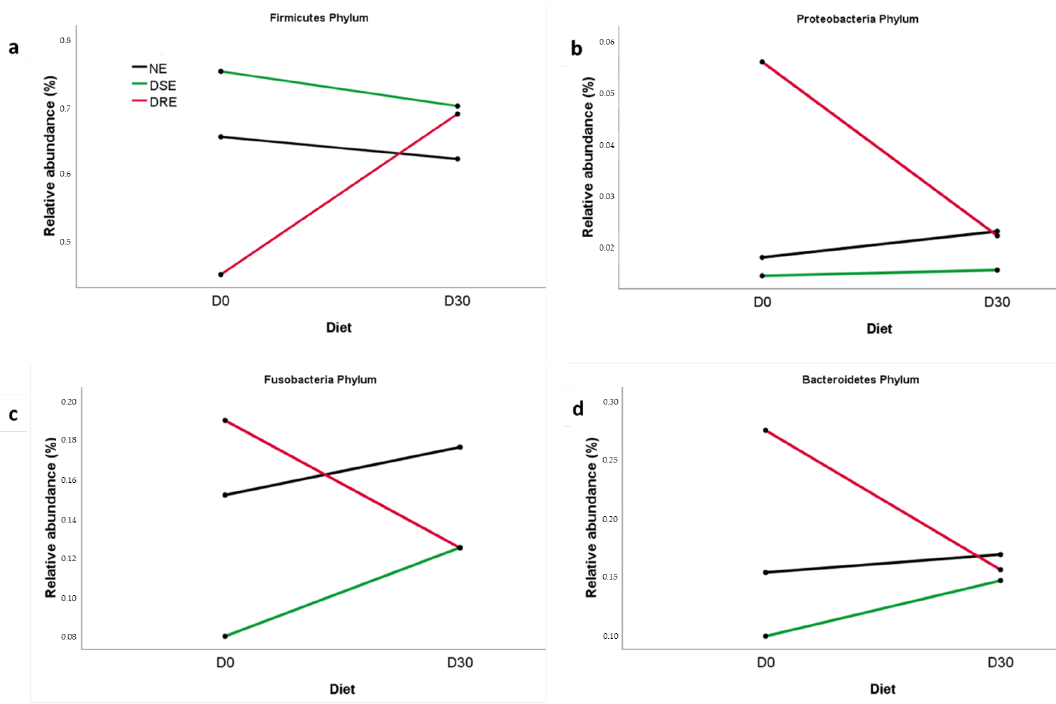
Figure 4. Means of ( a ) Firmicutes, ( b ) Proteobacteria, ( c ) Fusobacteria, and ( d ) Bacteroidetes at phy- lum level for non-epileptic (NE), drug-sensitive epilepsy (DSE) and drug-refractory epilepsy (DRE) groups, before (D0) and after one month on the MCT diet (D30).